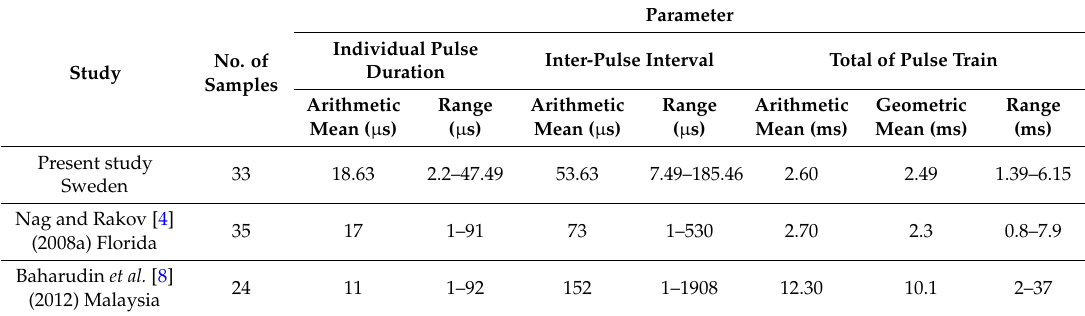
Table 2. Statistical presentation of the temporal features of preliminary breakdown (PB)